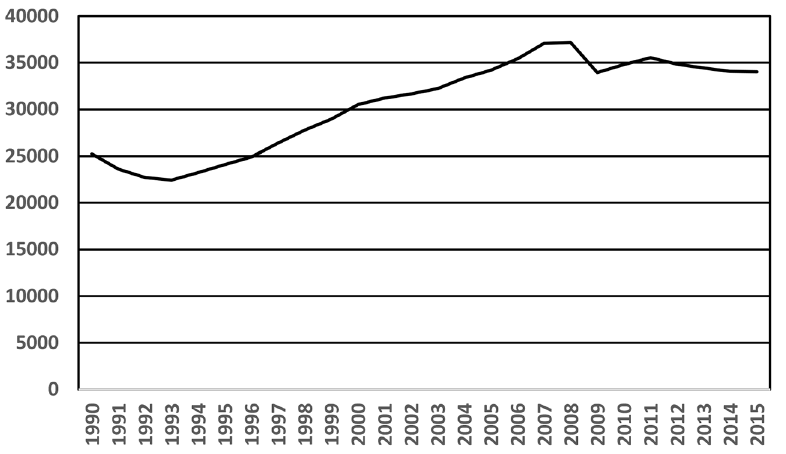
Figure 2. Economic development in Finland during the 1990-2015 period (GDP/Capita;